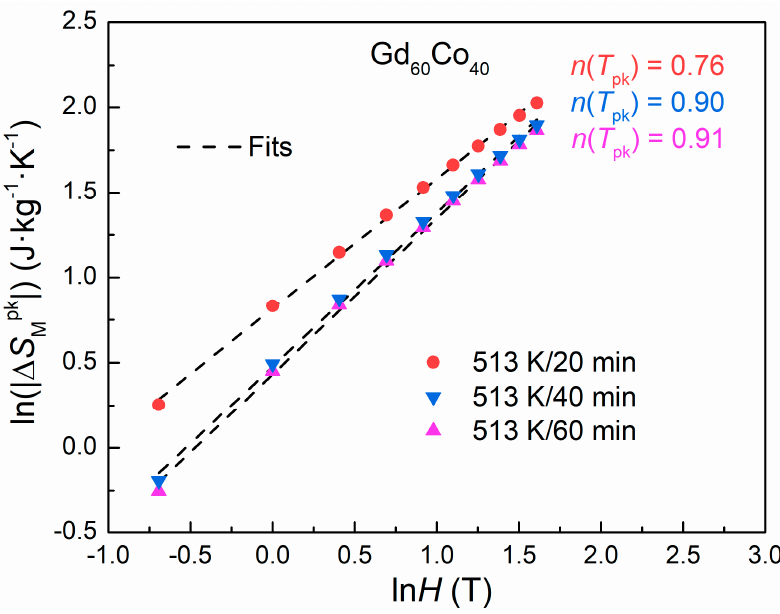
Figure 6. Ln–Ln plots of the field dependence of the | ∆ S Mpk | for calculating n ( T pk ) exponent of the annealed Gd 60 Co 40 alloys.